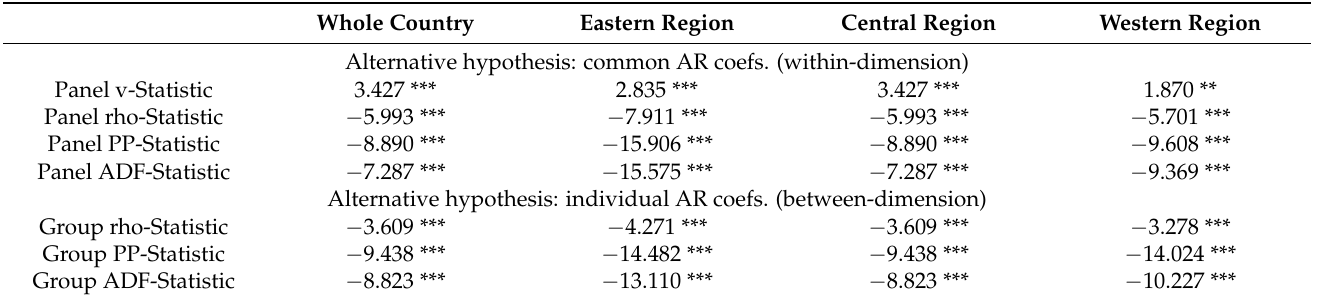
Table 4. The results of the Pedroni cointegration test. Whole Country Eastern Region